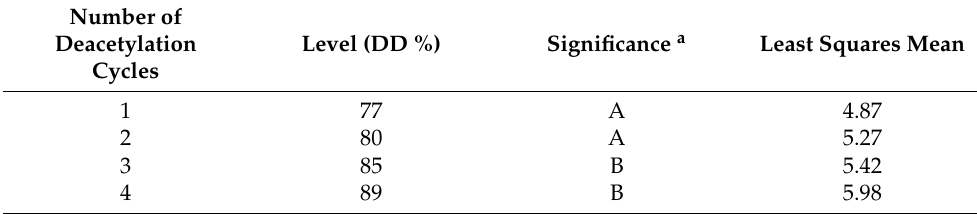
Table 7. Significance levels and least squares mean (Tukey HSD, α = 0.05) for the effect of degree